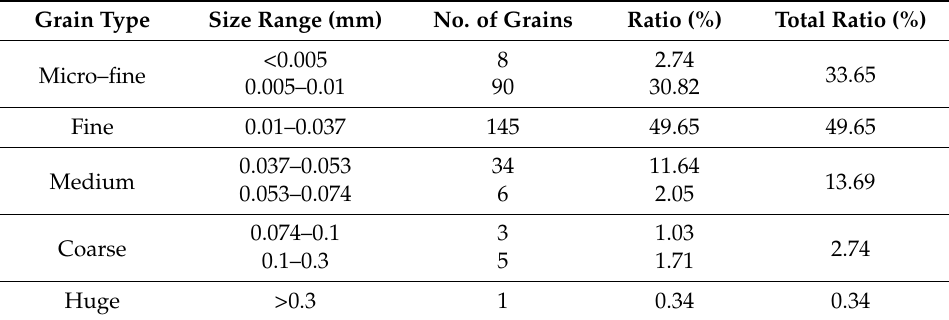
Table 2. Grain size distribution of the gold minerals.